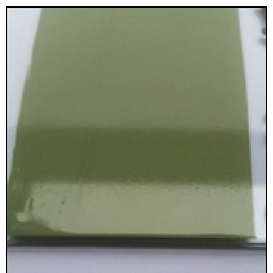
Figure 3. Excessive pinholes on the dried film coating of PA1 and PA2.